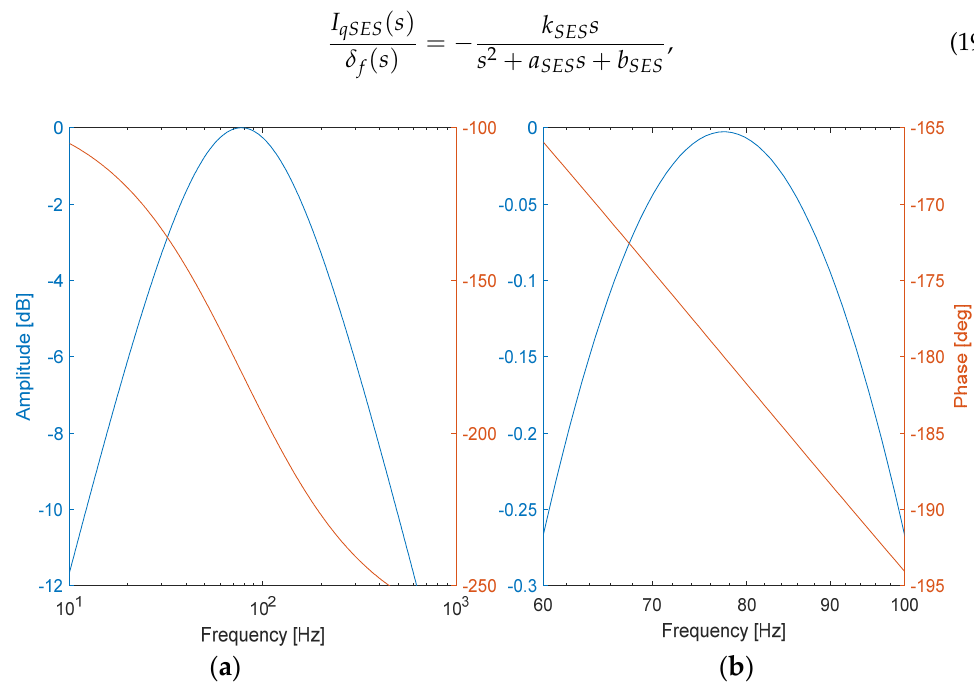
Figure 8. Bode diagram of the SES regulator (0 dB = 1 A/m): ( a ) behaviour from low to high frequencies; ( b ) detail in the frequency range where the first resonant pulsation of the ball-screw drivetrain is